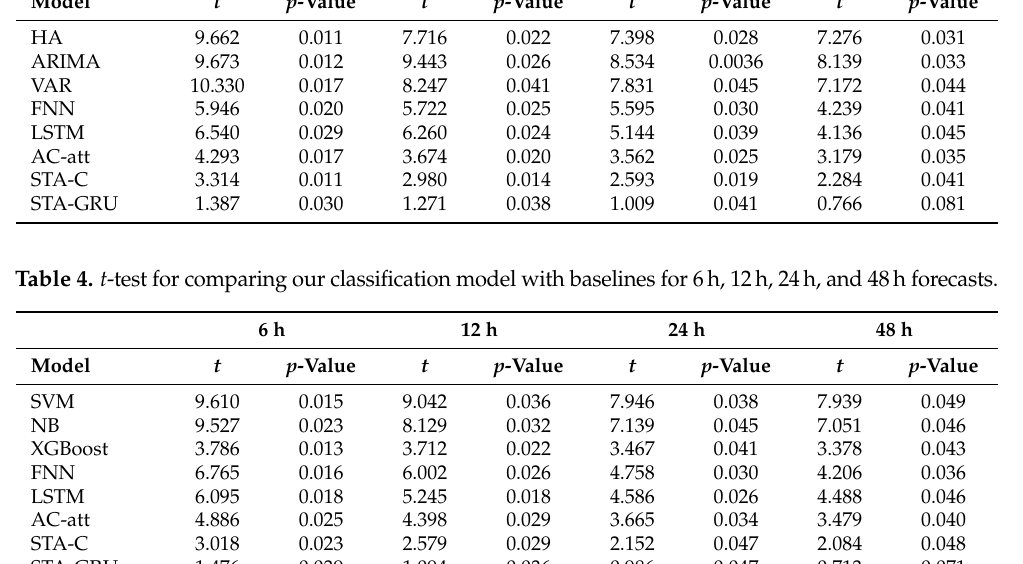
Table 3. t -test for comparing our regression model with baselines for 6h, 12h, 24h and 48h forecasts. 6 h